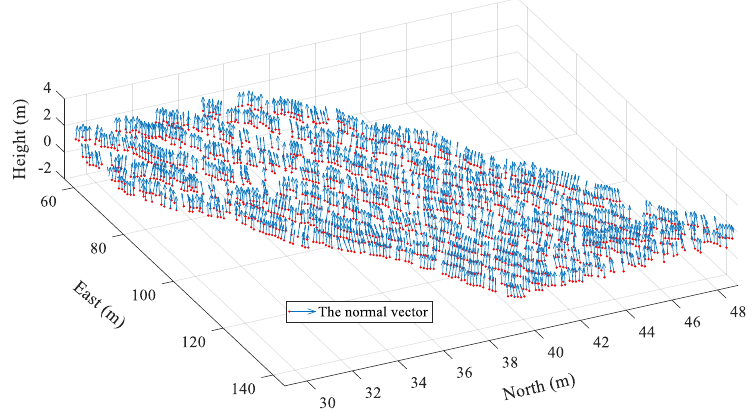
Figure 5. Schematic diagram of the normal vector of the laser incident on the sea surface.